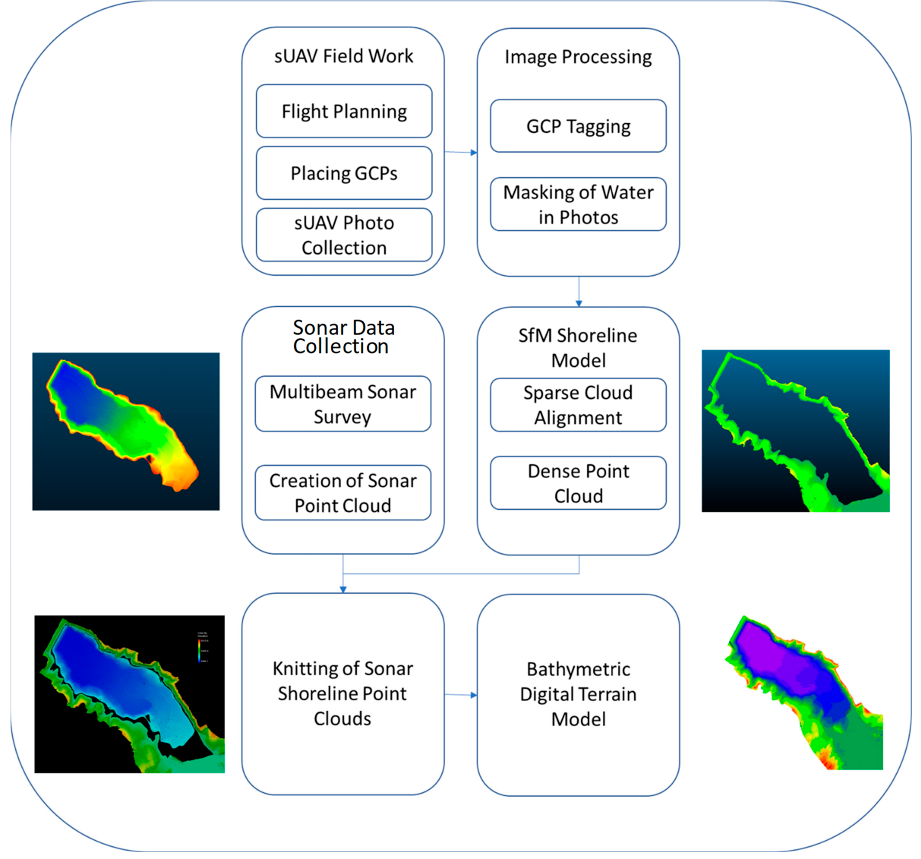
Figure 1. A flowchart of the process for creating a full-pool bathymetric dataset by merging above-water data generated using small unmanned aerial vehicle (sUAV) imagery and Structure from Motion (SfM) algorithms with multi-beam sonar data. This process relies on commercial software and sensors.